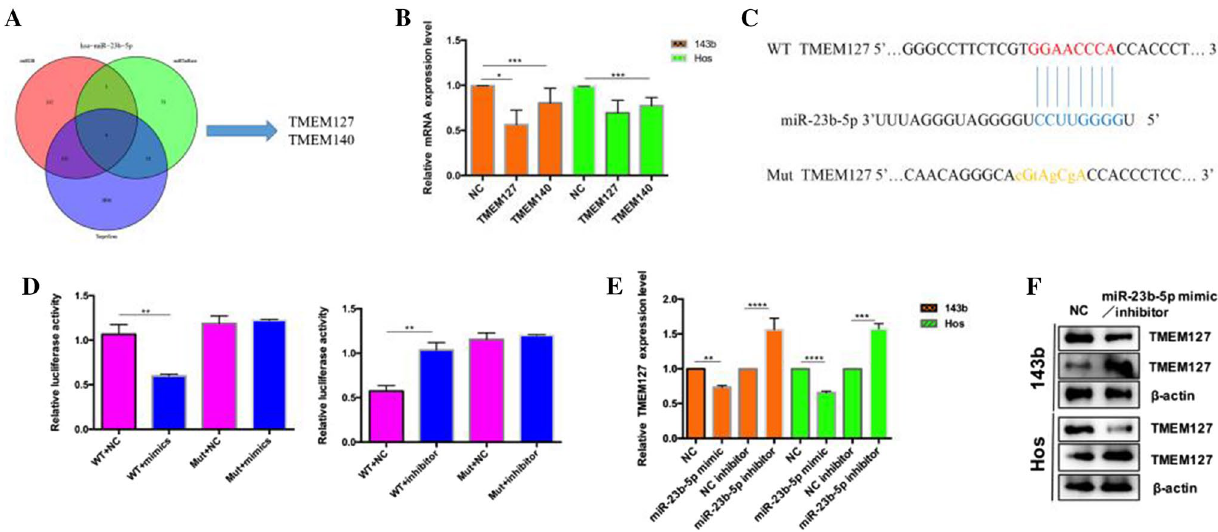
Fig. 3 TMEM127 is a direct target of miR-23b-5p. A Screening of target genes by intersection of three databases (miRDB, miRBase, and Tar- getScan). B qRT-PCR assessment of the expression levels of potential target genes in OS cells. C Schematic diagram of the base sequence between miR-23b-5p and TMEM127. D hHEK-293T cells were transfected with miR-23b-5p mimic or NC and wild-type or mutated TMEM127 3 ′ -UTR and subjected to luciferase assay. E The mRNA level of TMEM127 in OS cells was assessed by qRT-PCR. F The protein expression level of TMEM127 in OS cells was assessed by western blot. Results are shown as mean ± SD from three independent experiments. **P < 0.01